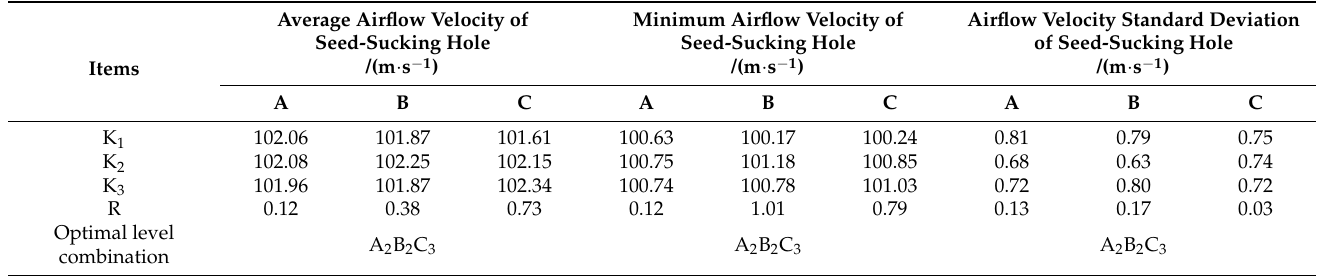
Table 3. Range analysis.